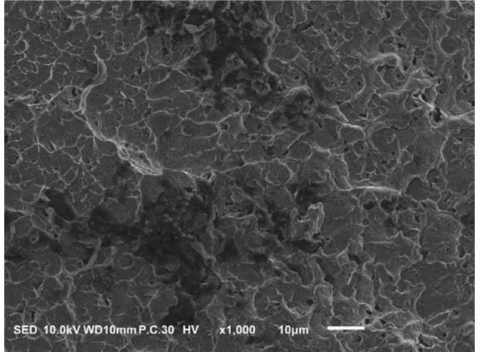
Figure 3. The SEM surface of PTN in dynamic cycles. There is no striation on the entire